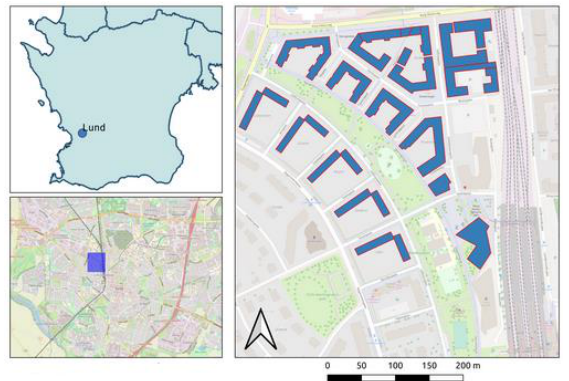
Figure 3. Study Area in Lund. Approximate coordinates of the area are 55.709°N and 13.186°E. Source data: OSM,